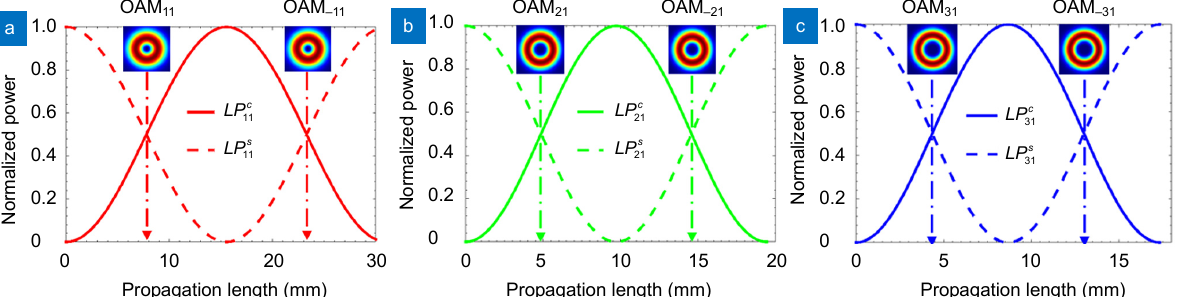
modes and s modes along the propagation length of IECFs. The intersection LP LP l l 1 1